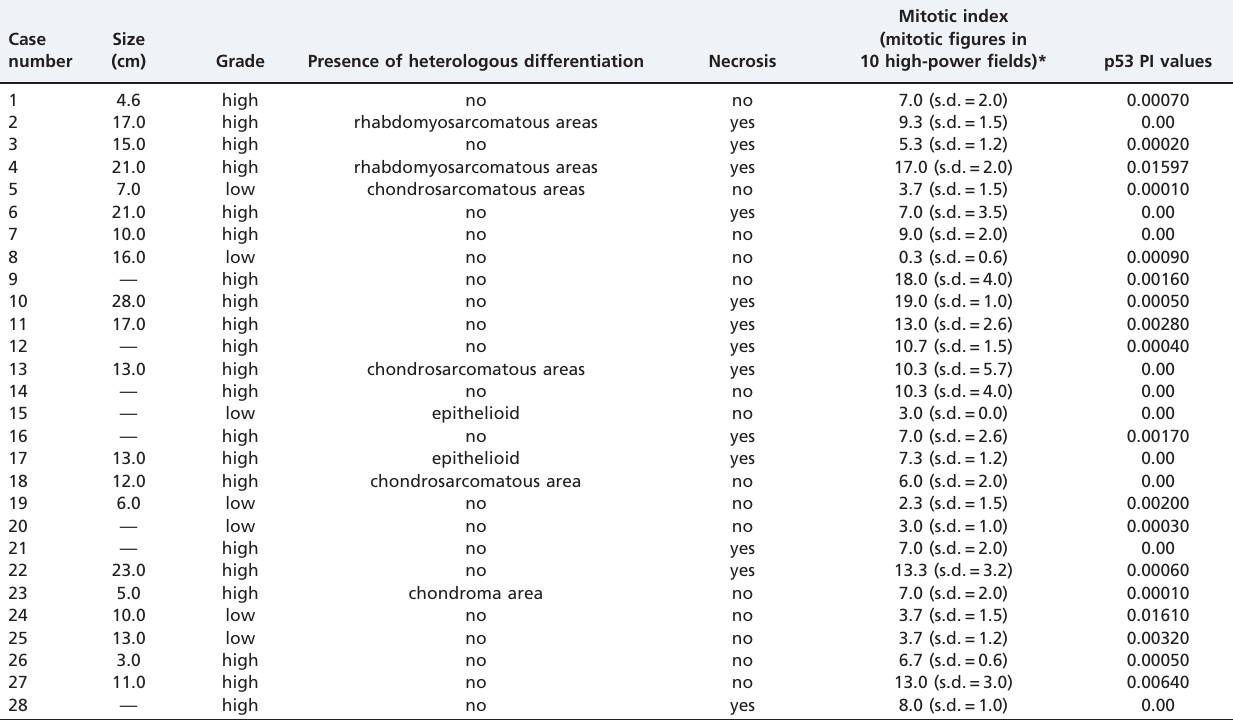
Table 2 - Pathological data of the malignant peripheral nerve sheath tumors. Case